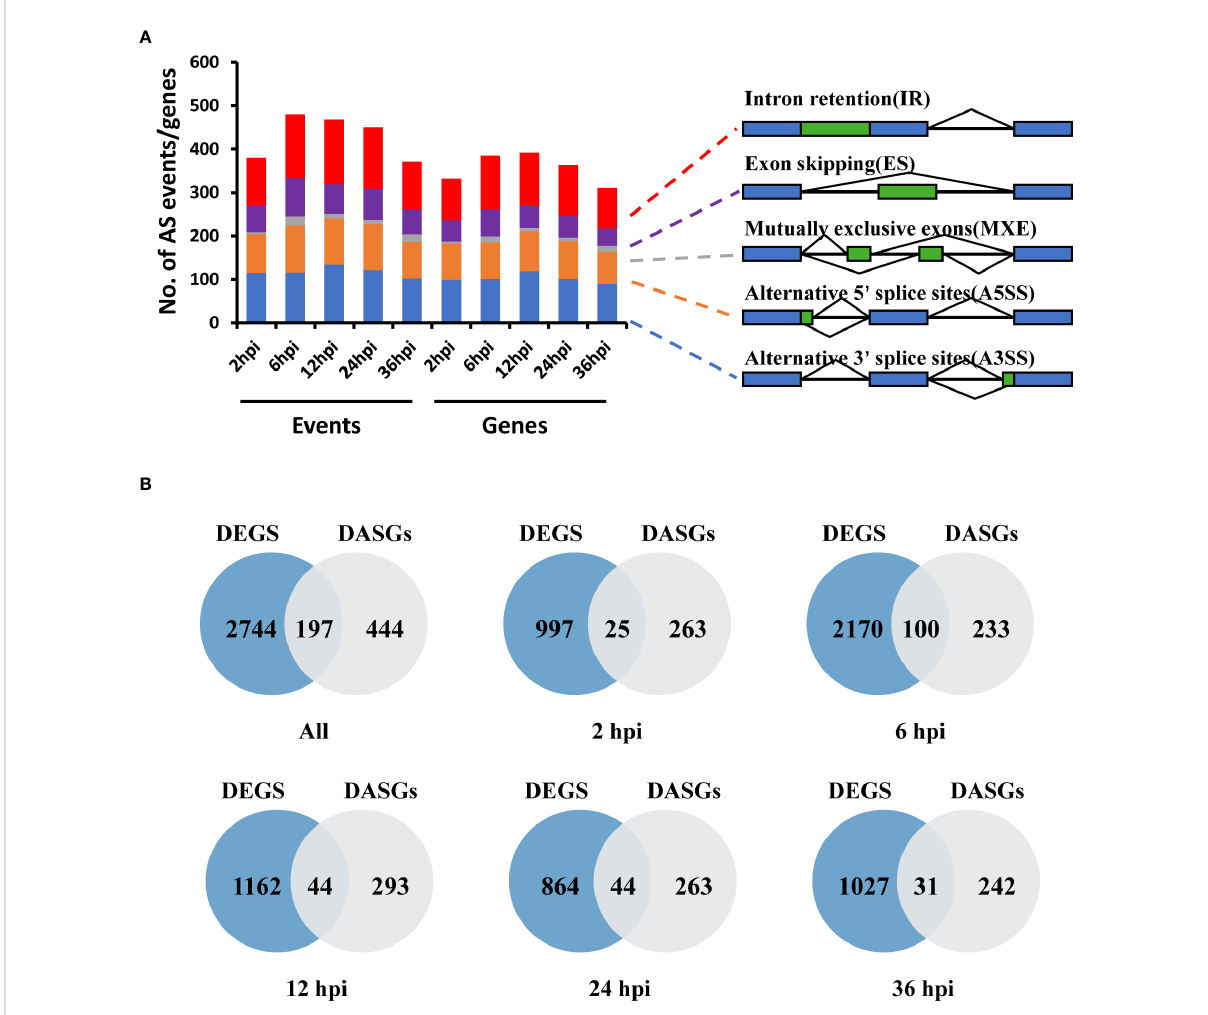
FIGURE 3 Differential alternative splicing genes (DASGs) and differentially expressed genes (DEGs) in S. sclerotiorum at different infection stages. (A) Number of different types of differentially expressing events and corresponding genes identi fi ed in different infected samples. A3SS, alternative 3 ′ splice site; A5SS, alternative 5 ′ splice site; ES, exon skipping; RI, retained intron; MXE, mutually exclusive exon. (B) Venn diagram of the overlap of DEGs and